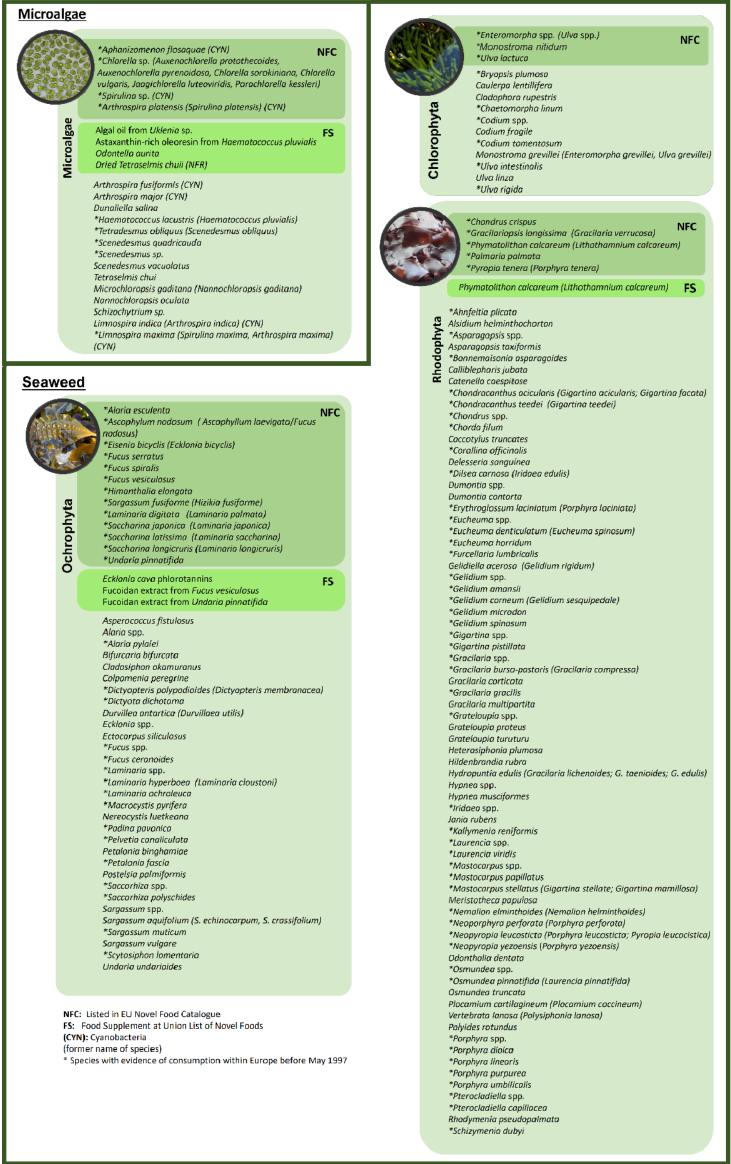
Figure 3. Algae species consumed in Europe, subdivided into Microalgae and Seaweeds (the Chloro- phyta, Phaeophyceae, and Rhodophyta groups). Highlighted novel food (NF) species are presented in the Novel Food Catalog; food supplements (FS) are those Food Supplements listed on the European Union list. Species with consumption evidence before 1997 are highlighted *. A detailed table with the common names and referenced evidence is given in the Supplementary Material (Table